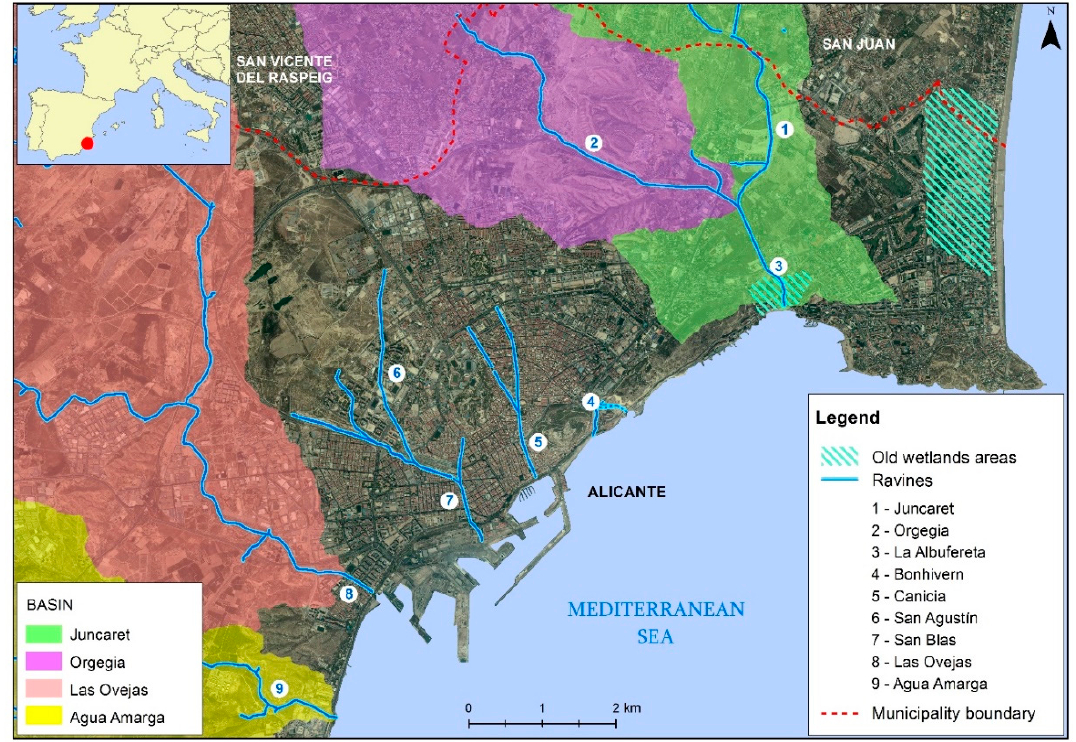
Figure 1. Watercourses and floodable areas incorporated into the city of Alicante. Own elaboration. Note: the ravines 4, 5, 6, and 7, due to urban growth, were incorporated into the urban core through their underground and channelling.